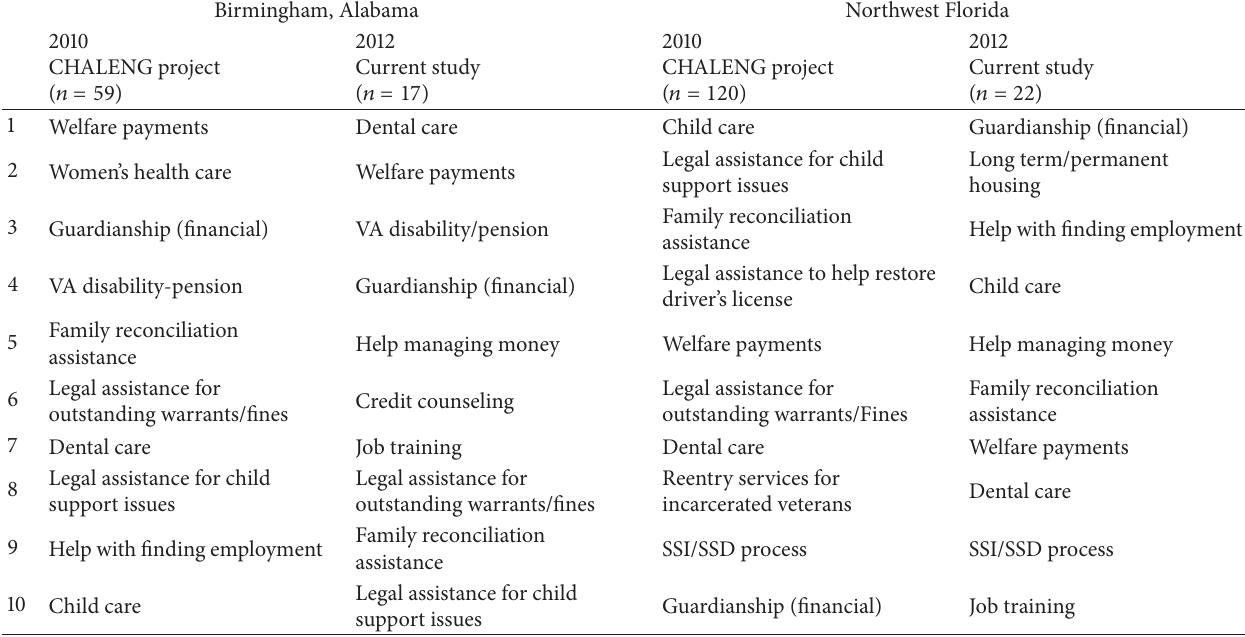
Table 2: Top ten highest unmet needs identified by homeless veterans in 2010 and